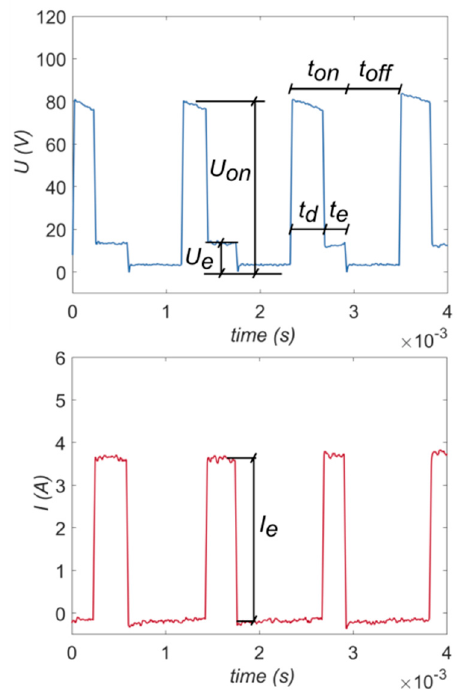
Figure 9. The recorded current and voltage waveforms.